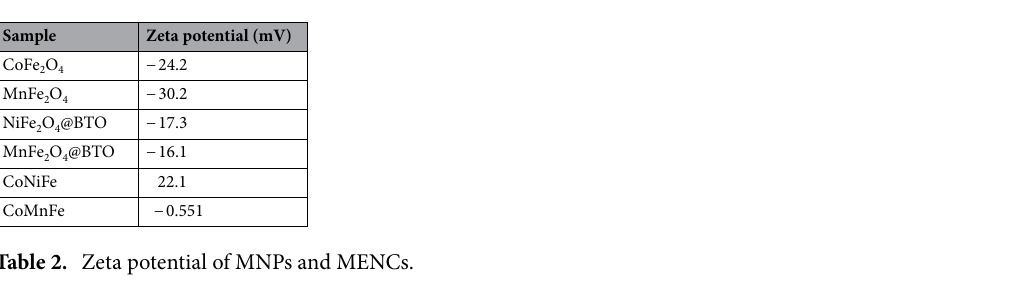
Table 2. Zeta potential of MNPs and